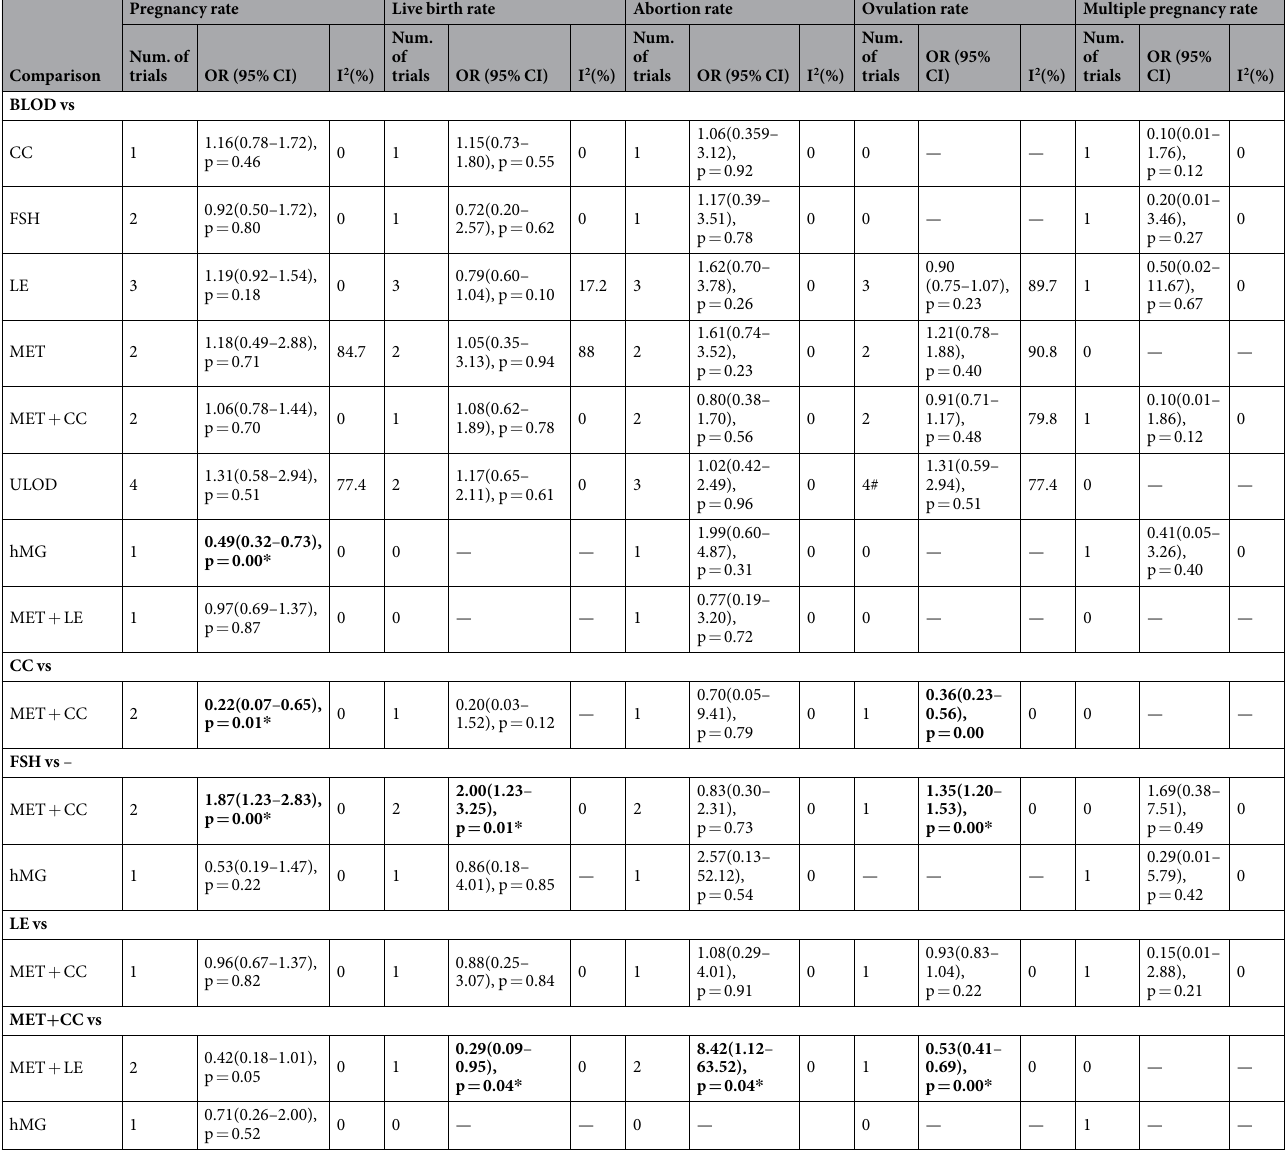
Table 2. Outcomes of direct comparisons of pregnancy rates, live birth rates, ovulation rates, abortion rates and multiple pregnancy rates. CC: clomiphene citrate, MET: metformin, LE: letrozole, FSH: follicle-stimulating hormone, hMG: human menopausal gonadotropin, MET + CC: metformin combined with clomiphene citrate, MET + LE: metformin combined with letrozole, ULOD: unilateral laparoscopic ovarian drilling, BLOD: bilateral laparoscopic ovarian drilling. CI: confidence interval; p < 0.05 * indicates significant difference. “—” indicates “not available”. #: ovulation rate per intention to